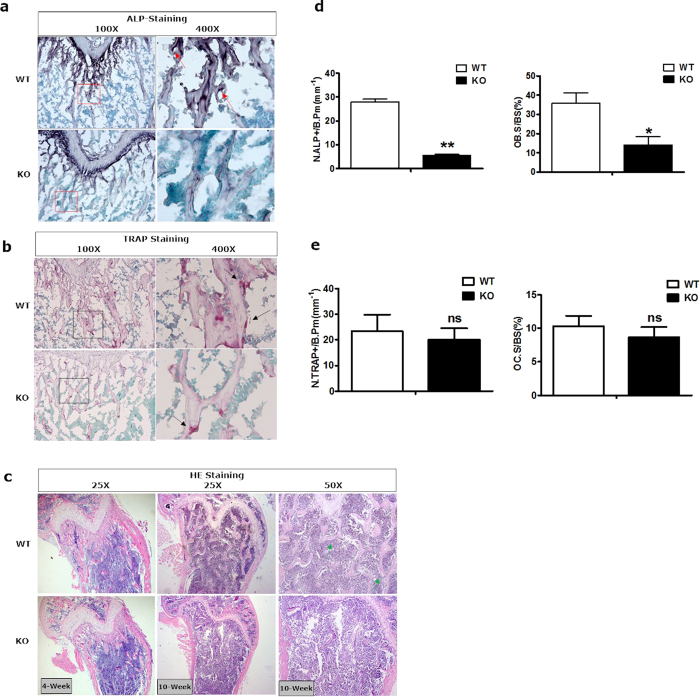
Bone-specific conditional knockout of PKD1 impaired osteoblasts development in the distal femur.(a) The activity of ALP was stained with purple in the membrane of osteoblast, as showed by red arrows. (b) The activity of TRAP was stained with red in osteoclasts, as showed by black arrows. (c) H&E staining of distal femur from 4 and 10 weeks KO and littermate control mouse. The green arrow indicated the trabecular bone. (d) Number of ALP positive cells/per bone perimeter (mm−1) (N.ALP+/B.Pm), osteolast surface per bone surface (OB.S/BS%). Measurements are presented as mean ± SD. *p < 0.05 versus respective control by t test. (e) Histomorphometric analysis showing no difference in osteoclast number per bone perimeter (mm−1) (N.TRAP+/B.Pm), and normal osteoclasts surface per bone surface (OC.S/BS,%) of WT and KO mice.